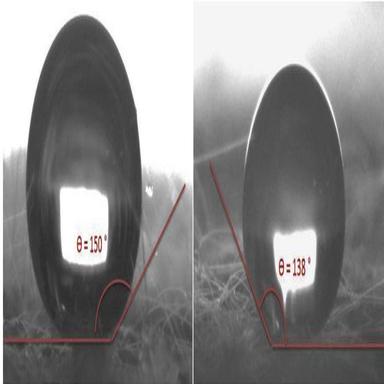
Contact angle between a water droplet and aerogel blanket (left), needle glass fibers (right).